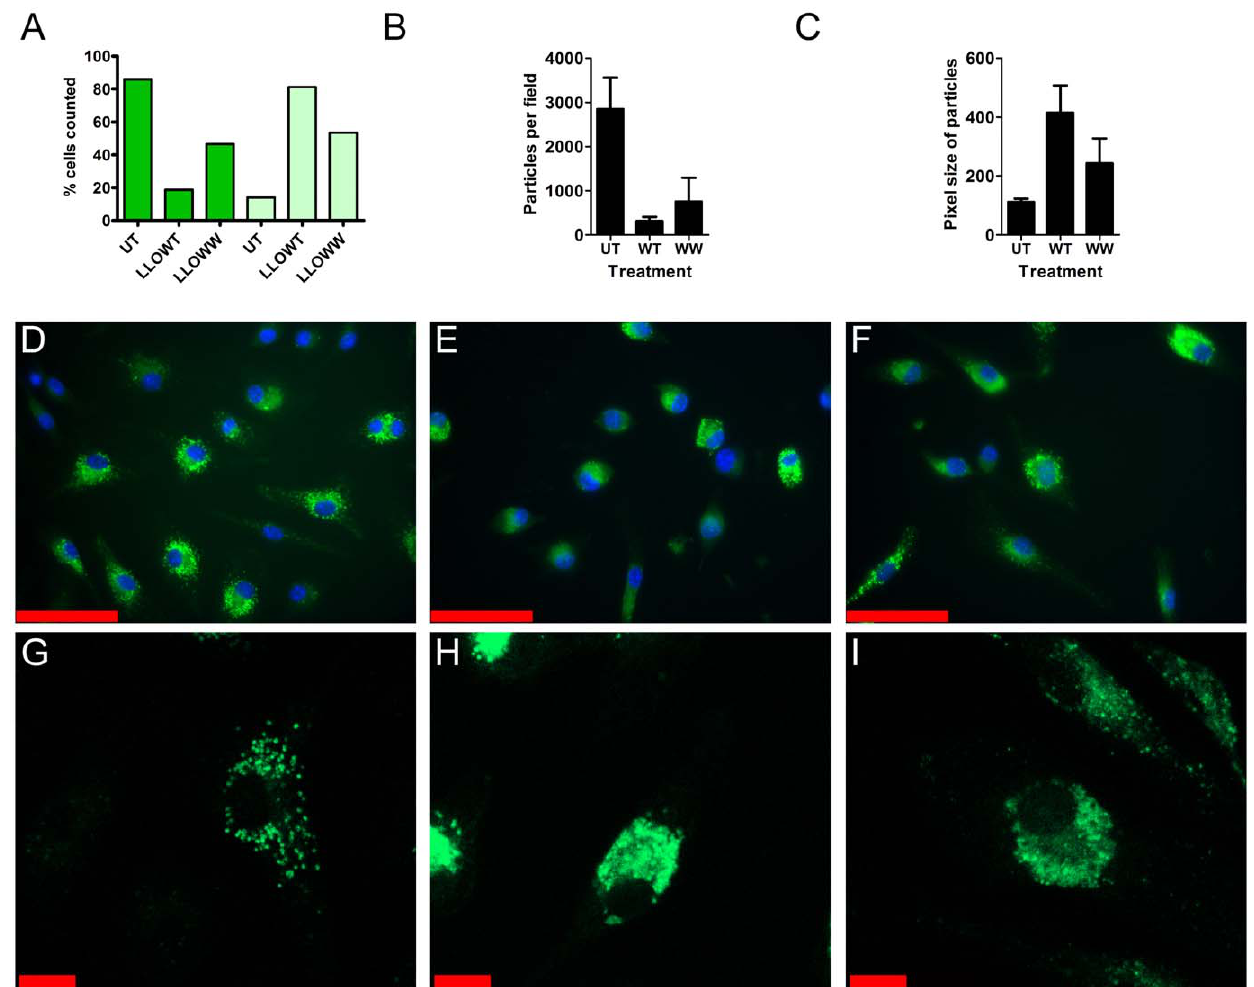
Figure 2. Release of vesicular dextrans into the cytosol. A–I. BMM (1.25 6 10 5 ) were adhered to 12 mm coverslips and treated with FITC- dextran for 30 min then either left untreated ( D,G ) or treated with LLOWT ( E,H ) or LLOWW ( F,I ) for 4 hours. A. The number of cells containing punctate staining was determined by counting , 100 individual cells for each treatment. A cell was considered to have puncta if it had any visible discrete spots, as in panel G . Cells were considered to have no puncta if the green staining was homogeneous, as in panel H . B–C. ImageJ analysis of the number of particles and size of particles per field was determined as detailed in the materials and methods. Bars represent the mean + / 2 S.D. particles per field ( B ) or pixel size of particles ( C ) for three independent fields with 10–24 cells per field. D–F. Representative epiluminescence images taken following treatment with FITC-Dextran and then either left untreated ( D ) or treated with 1 nM LLOWT ( E ) or 10 nM LLOWW ( F ). The nucleus (DAPI) was false colored blue and FITC-Dextran was false colored green. G–H. Representative laser scanning micrographs of FITC-dextran loaded BMM either untreated ( G ) or treated with 1 nM LLOWT ( H ) or 10 nM LLOWW ( I ). Scale bars in represent 50 m m ( D–F ) or 10 m m ( G–I ). Microscopy is representative of 2 independent experiments performed in